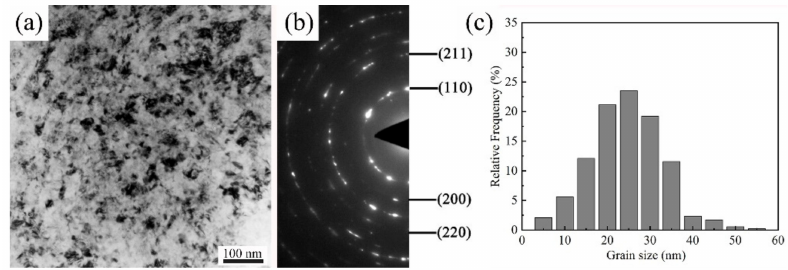
Figure 10. ( a ) TEM image of the top surface layer of the sample RASP-processed for 5 min; ( b ) the corresponding selected-area electron di ff raction (SAED) pattern in ( a ); ( c ) grain size distribution in the top surface layer.